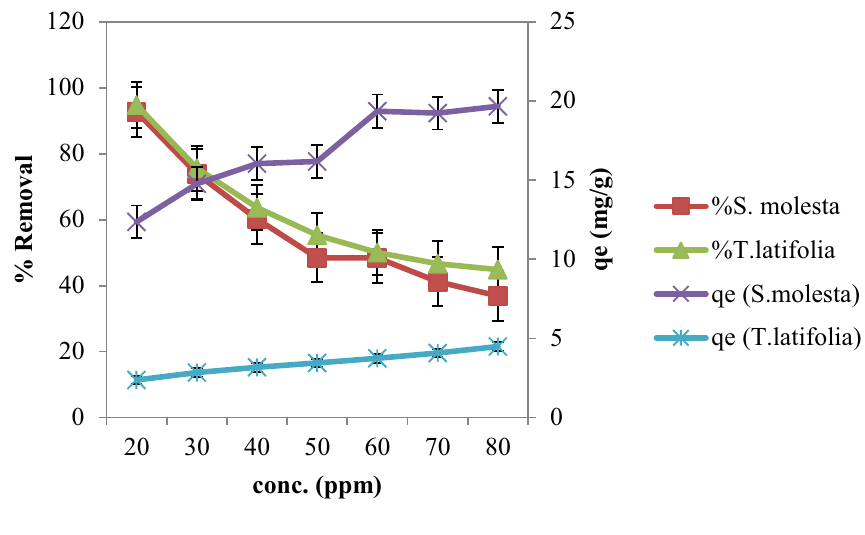
Fig. 6 Effect of initial metal concentration on Cr 6+ adsorp- tion by S. molesta and T. Latifolia